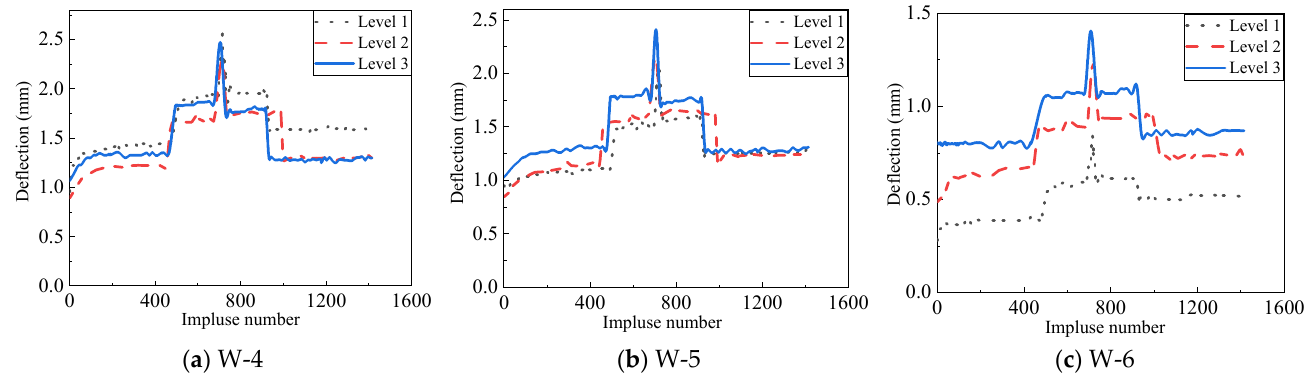
Figure 9. Deflection histories of the measurement points at half-height of the specimen.